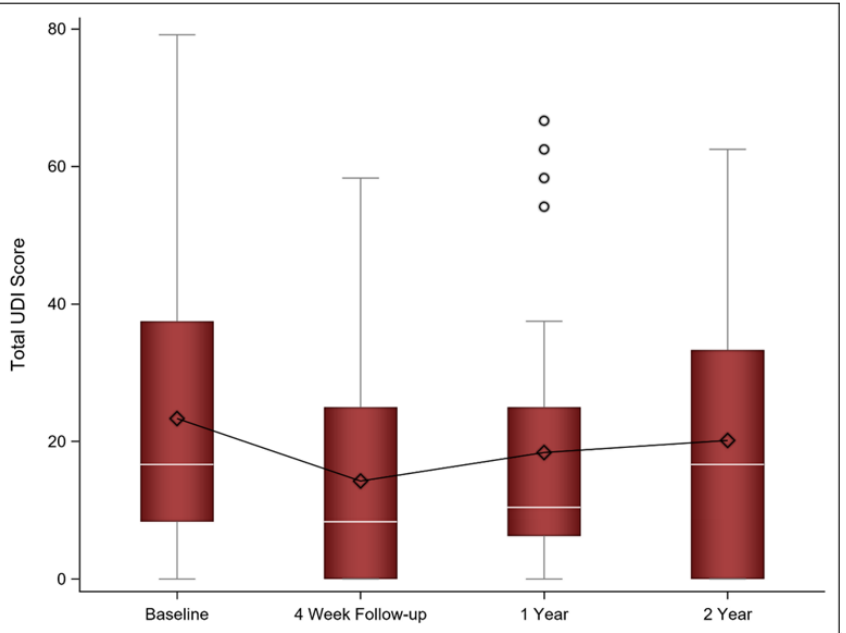
Figure 4. Mean (diamond), median (white line), and the 1st and 3rd quartiles are displayed for the UDI at baseline, 4 week, and 1 and 2 year follow ‐ ups. The whiskers are the distance equal to 1.5 times the interquartile range (IQR). The diagram also shows outliers (circles) which are values that above or below the whisker ends. UDI = Urinary Distress Inventory